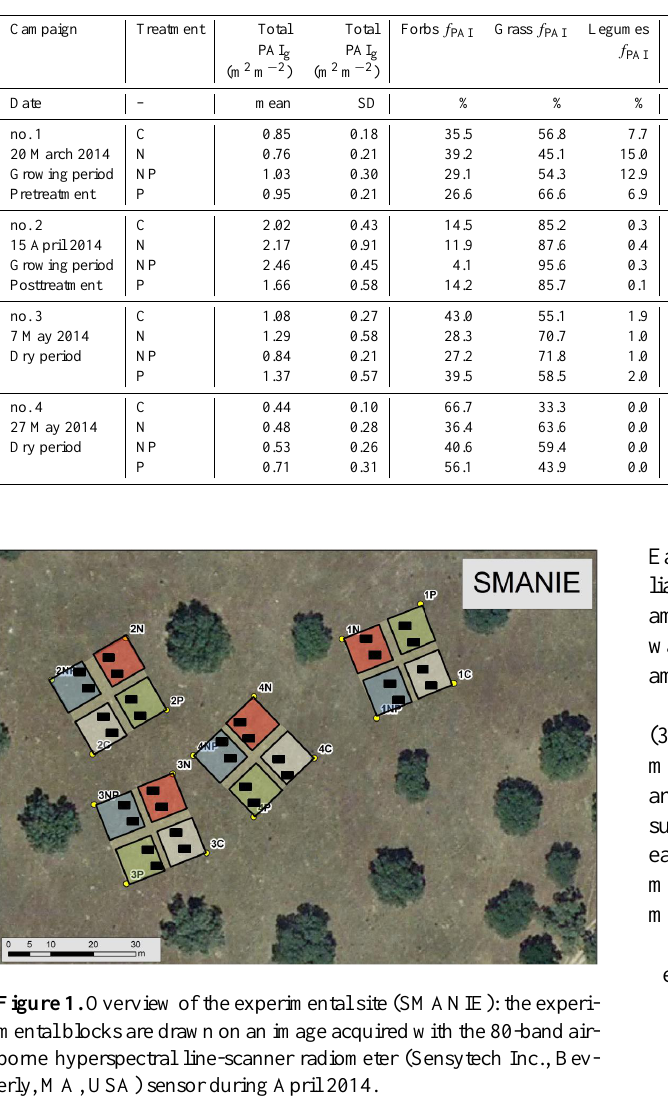
Table 1. Ancillary data resulting from the analysis. Green plant area index (PAI g ), fraction of PAI in different plant forms ( f PAI ), and C, N, and P plant content. The N:P ratio also is shown. Data correspond to the mean value and standard deviation (SD) of the subsamples taken in each plot and treatment.